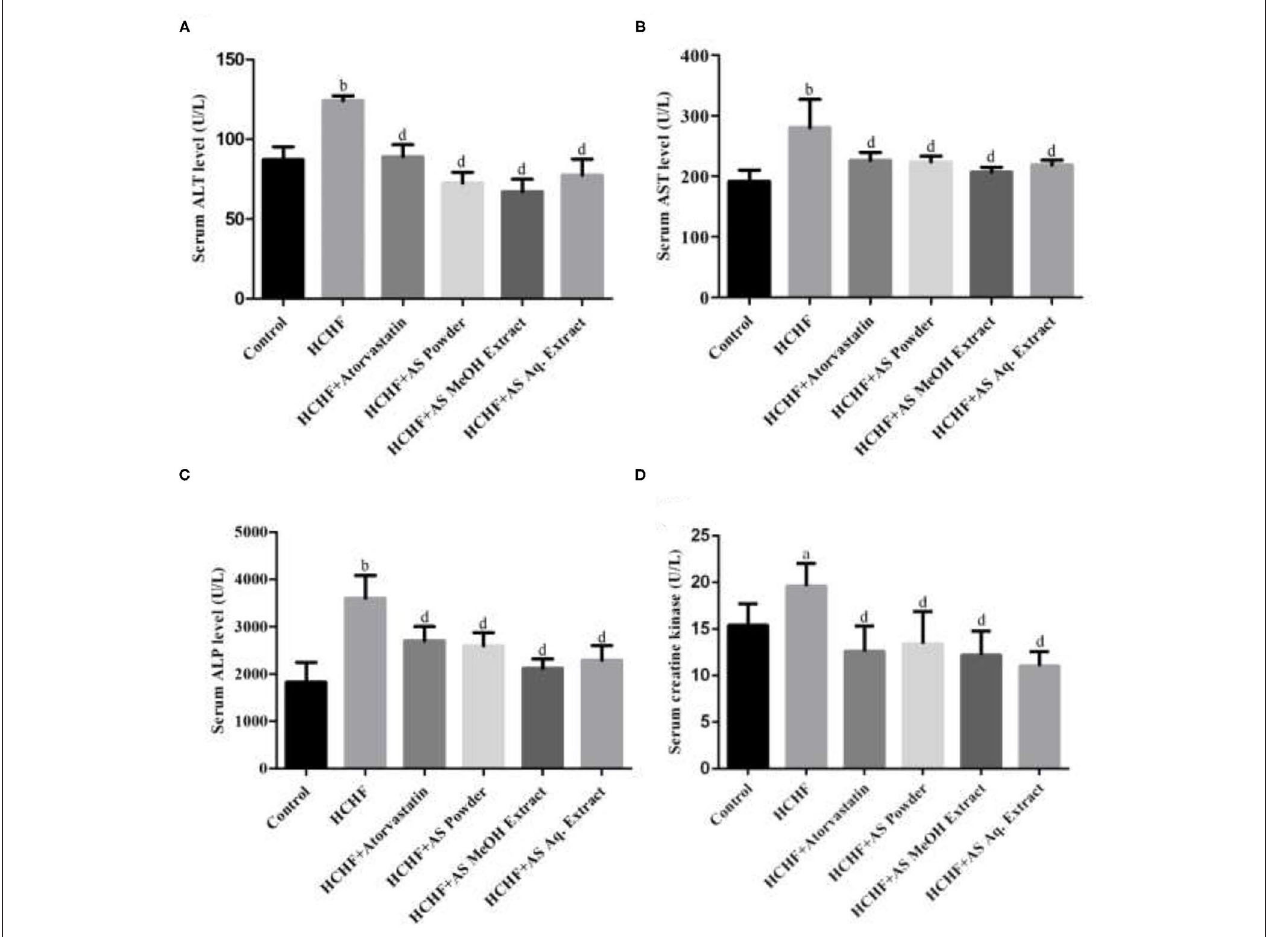
FIGURE 4 | Effect of Amaranthus spinosus on serum (A) Alanine transaminase (ALT), (B) aspartate transaminase (AST), (C) alkaline phosphatase (ALP), and (D) creatine kinase levels in HCHF diet-induced obese rats. Values are presented as mean ± SD, where n = 5. a p < 0.05, b p < 0.005 vs. control; d p < 0.005 vs. HCHF.